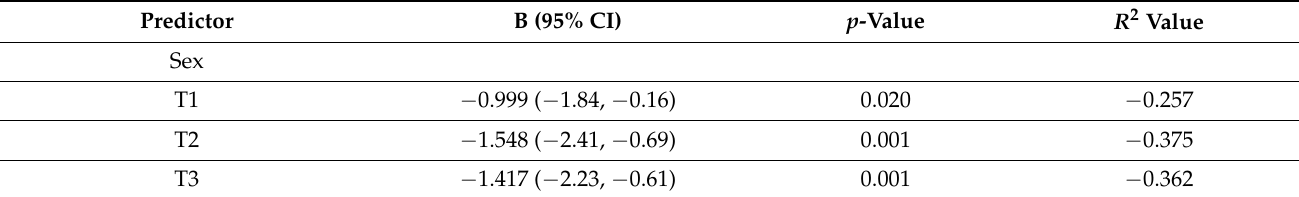
Table 1. Linear regression of pain after TKA, based on mean pain levels of the first postoperative week in the acute hospital (T1), the second week until the fourth postoperative week in the rehabilitation unit (T2), and the total analyzed postoperative time (T3); KSS1: knee society score preoperative; FS1: functional score preoperative; KSS2 and FS2 after one week in the acute hospital; and KSS3 and FS2 after four weeks in a rehabilitation